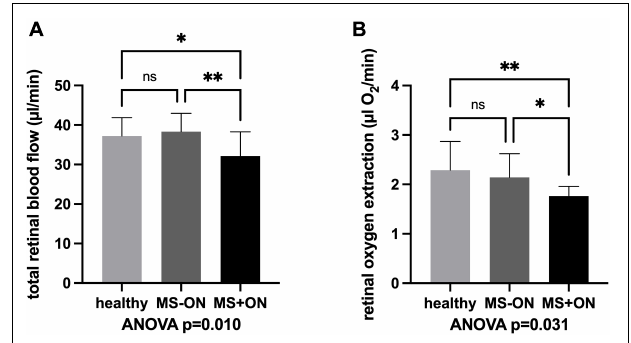
FIGURE 1 | Total retinal blood flow (A) and retinal oxygen extraction (B) in eyes with history of acute optic neuritis (MS+ON), in contralateral eyes with no history of ON (MS-ON) and healthy control eyes are significantly different between the study groups upon ANOVA analysis. MS+ON eyes showed significantly reduced total retinal blood flow and oxygen extraction as compared to MS-ON and healthy eyes. Data are presented as means ± standard deviation. ∗ p < 0.05, ∗∗ p < 0.01, ns, not